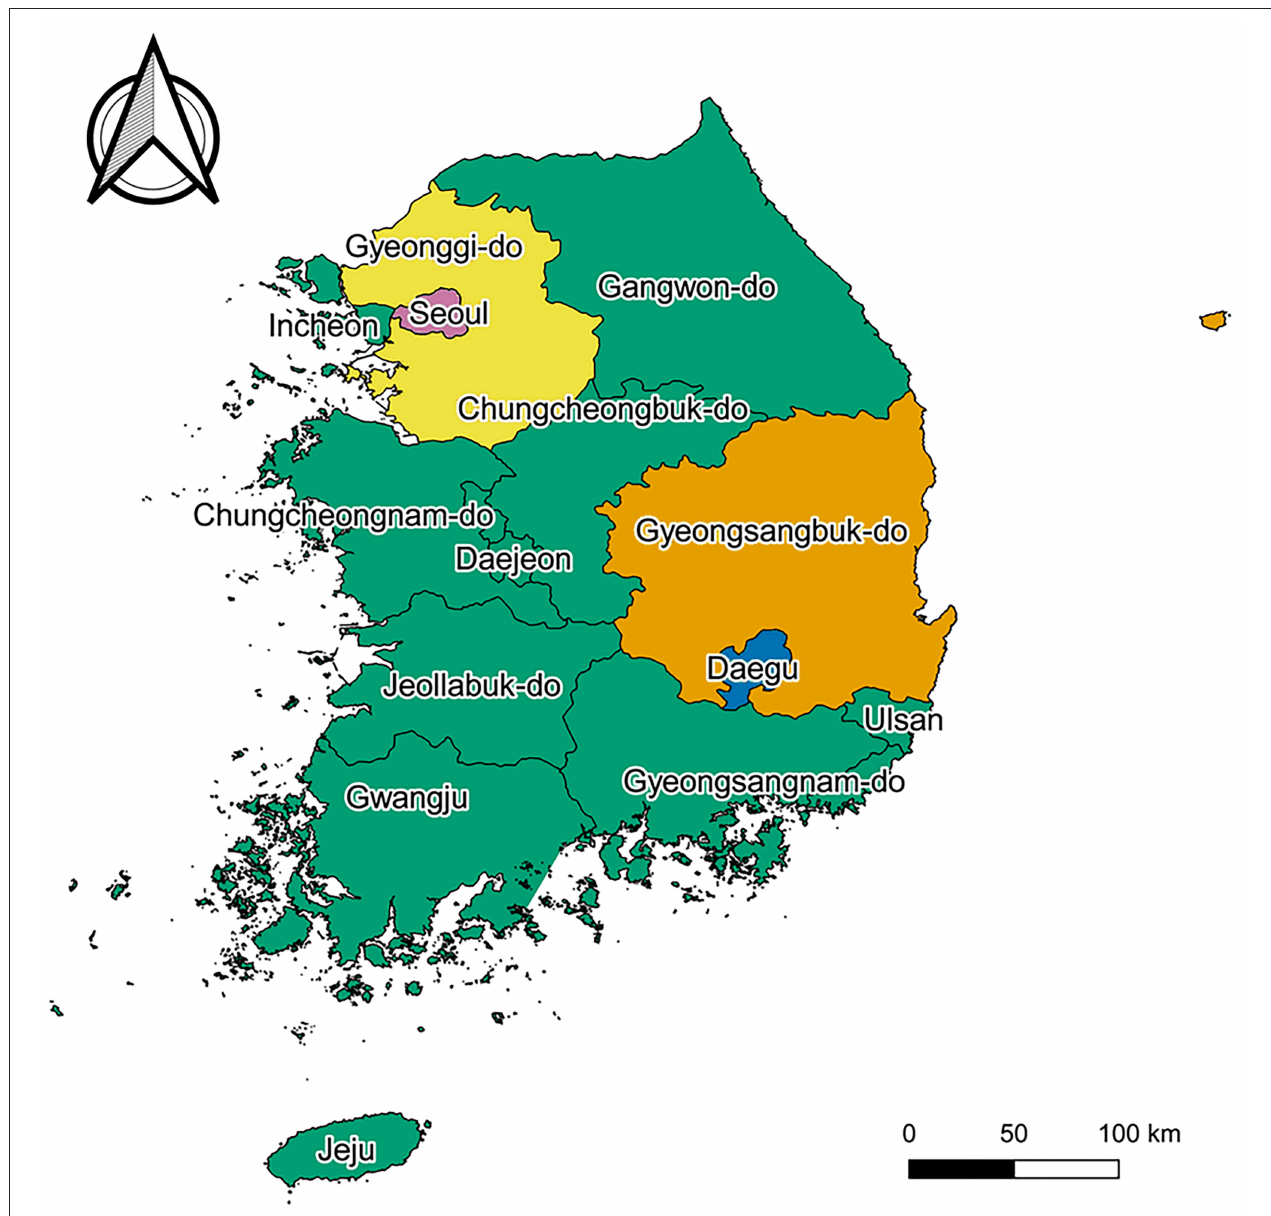
FIGURE 1 | Map of South Korea. Pink, yellow, blue, orange, and green regions represent “Seoul,” “Gyeonggi-do,” “Daegu,” “Gyeongsangbuk-do,” and “others,” respectively. Map created by Kim et al. (2021), using QGIS version 3.10.13 (QGIS Development Team, http://qgis.osgeo.org). The Shapefile used in this figure was obtained from “South Korea level 1” of GADM data version 3.6 (https://gadm.org/download_country_v3.html), the data to create maps for academic publishing is freely available (License suggested: